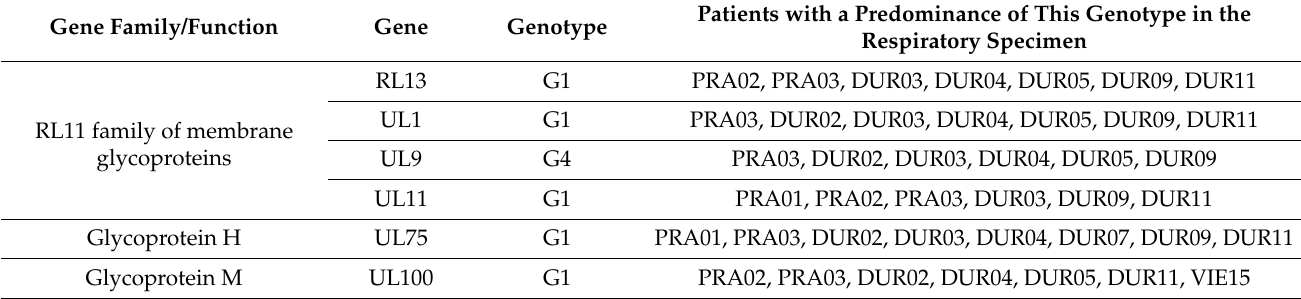
Table 3. Genotypes more predominant in respiratory